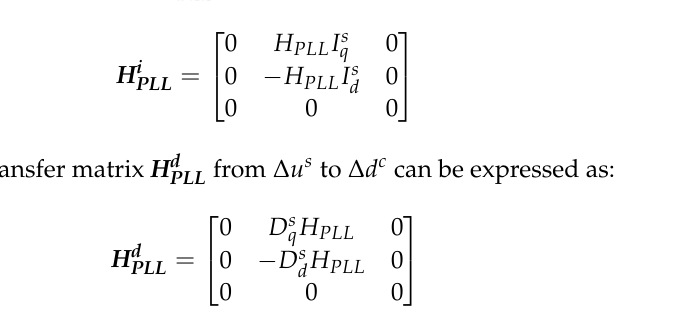
g C Figure 5. Circuit model of LCL-TFSCI connected to the grid with parallel compensation capacitors.